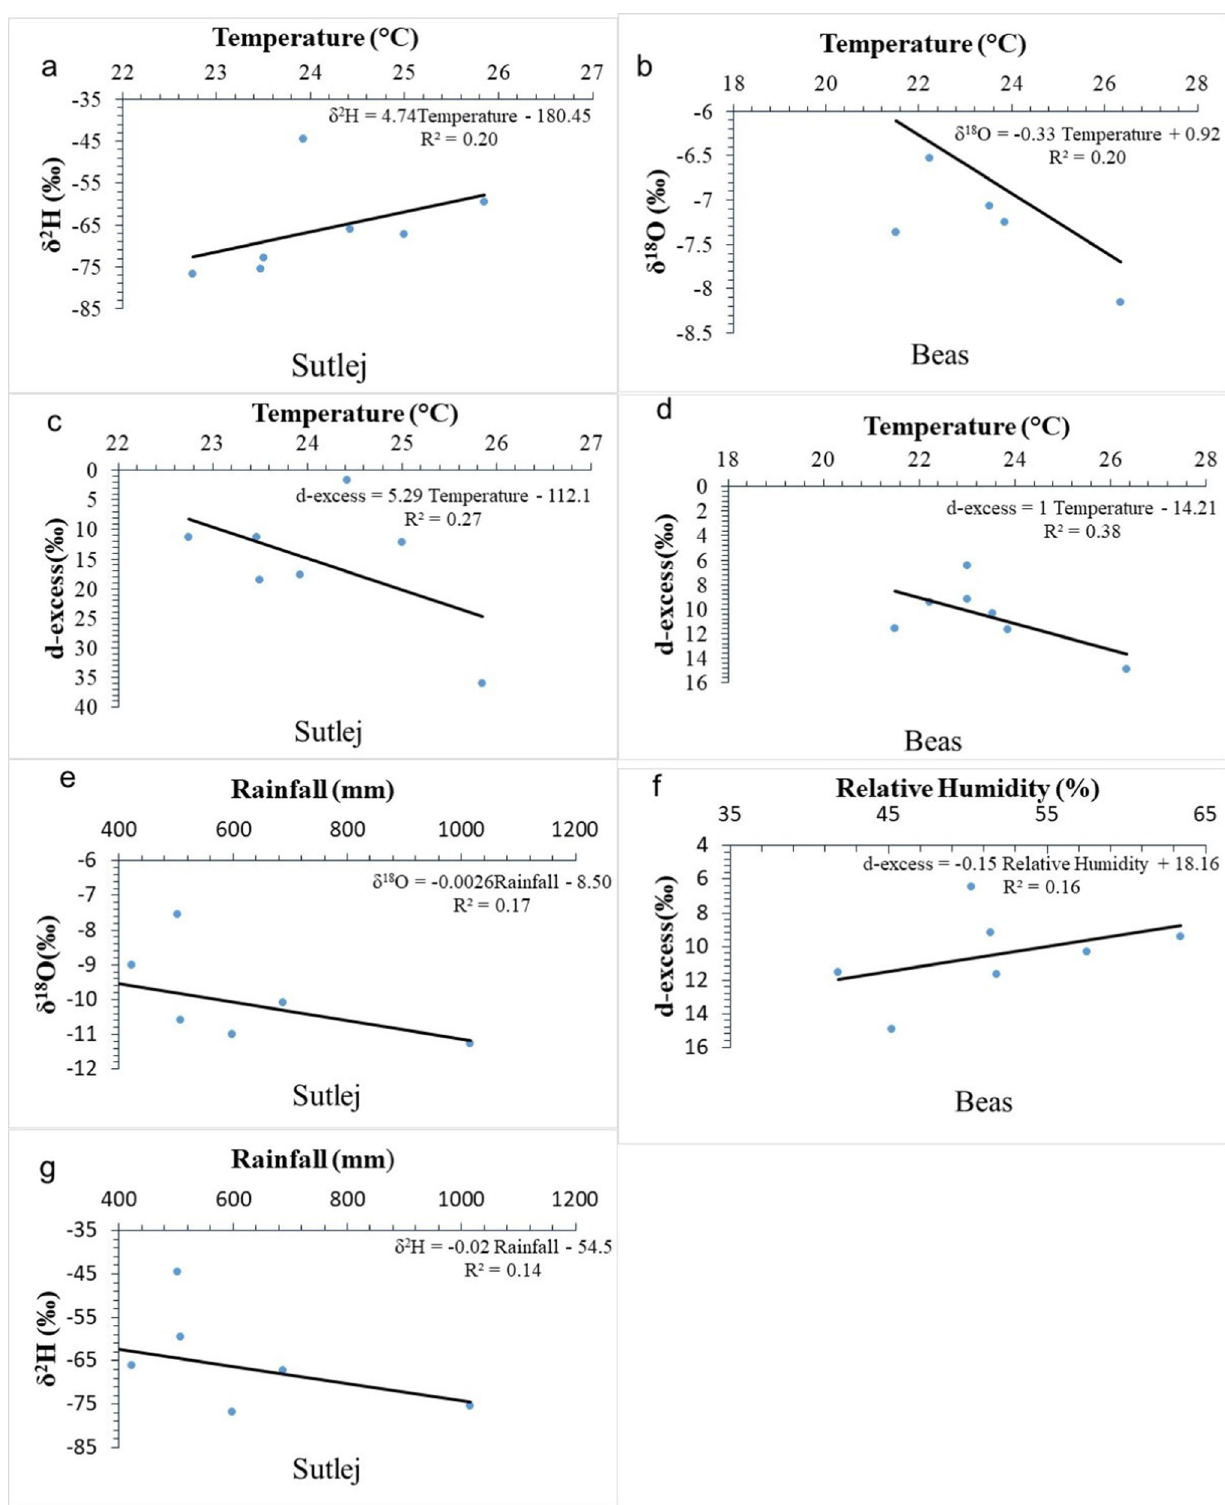
Fig. 12 The linear regression relationships are shown in a δ 2 H and temperature for River Sutlej, b δ 18 O and temperature for River Beas, c d-excess and temperature for River Sutlej, d d-excess and temperature for River Beas, e δ 18 O and rainfall for the River Sutlej, f d-excess and relative humidity for River Beas, g δ 2 H and rainfall for River